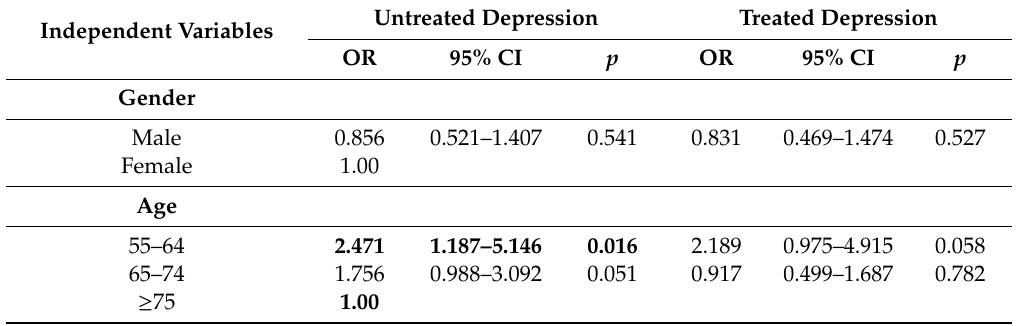
Table 2. Multinomial logistic regression on factors associated with treated depression and depressed but with no medical care, compared to no